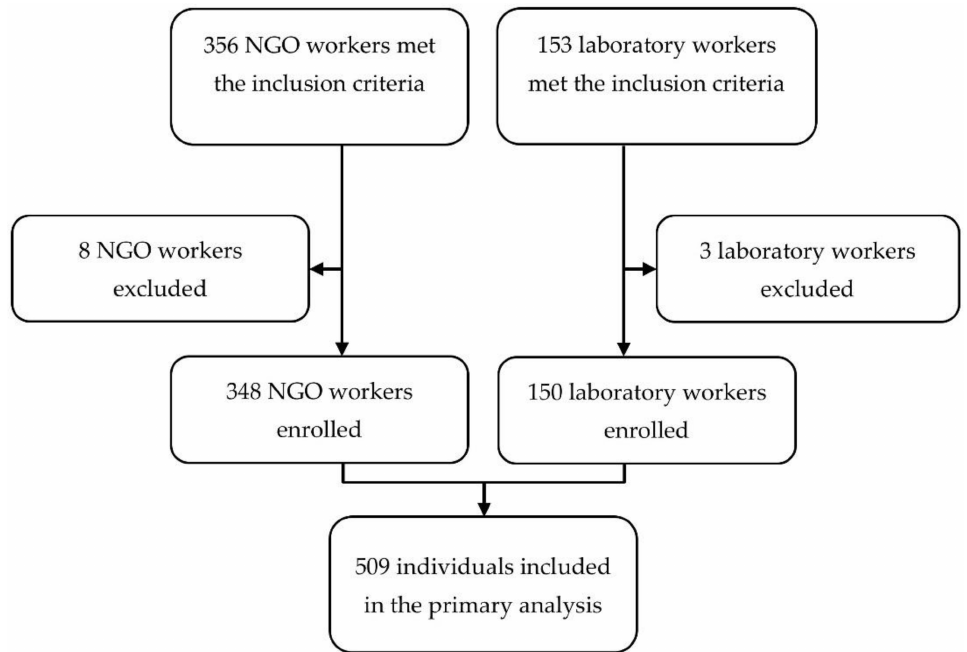
Figure 1. Study flow